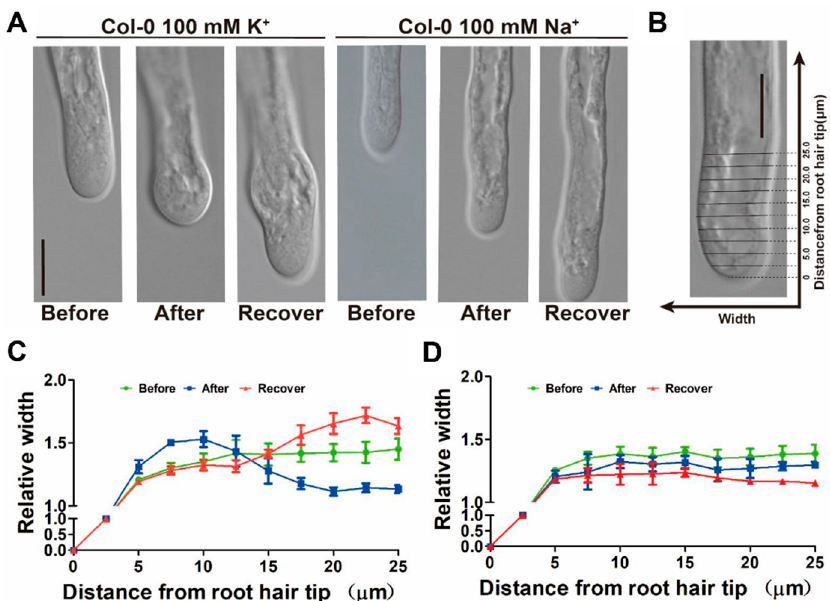
Figure 4. E ff ects of exogenous K + on the growth of Arabidopsis root hairs: ( A ) Time-lapse bright-field images of root hairs under 100 mM KCl or NaCl treatment. After K + treatment, a swelling structure formed at the root hair tips within 5 min and recovered to normal structure in the following 5–10 min. Under the same concentration of Na + , there was no such structure. Bar = 10 µ m; ( B ) The representative scheme of measurement of root hair width at a certain position from the root hair tip. Bar = 10 µ m; ( C , D ) Quantification of the width of root hairs in A. Curvature represents the average width at di ff erent positions (mean ± s.d.) in six hairs. ( C ) Under 100 mM KCl treatment and ( D ) under 100 mM NaCl treatment.